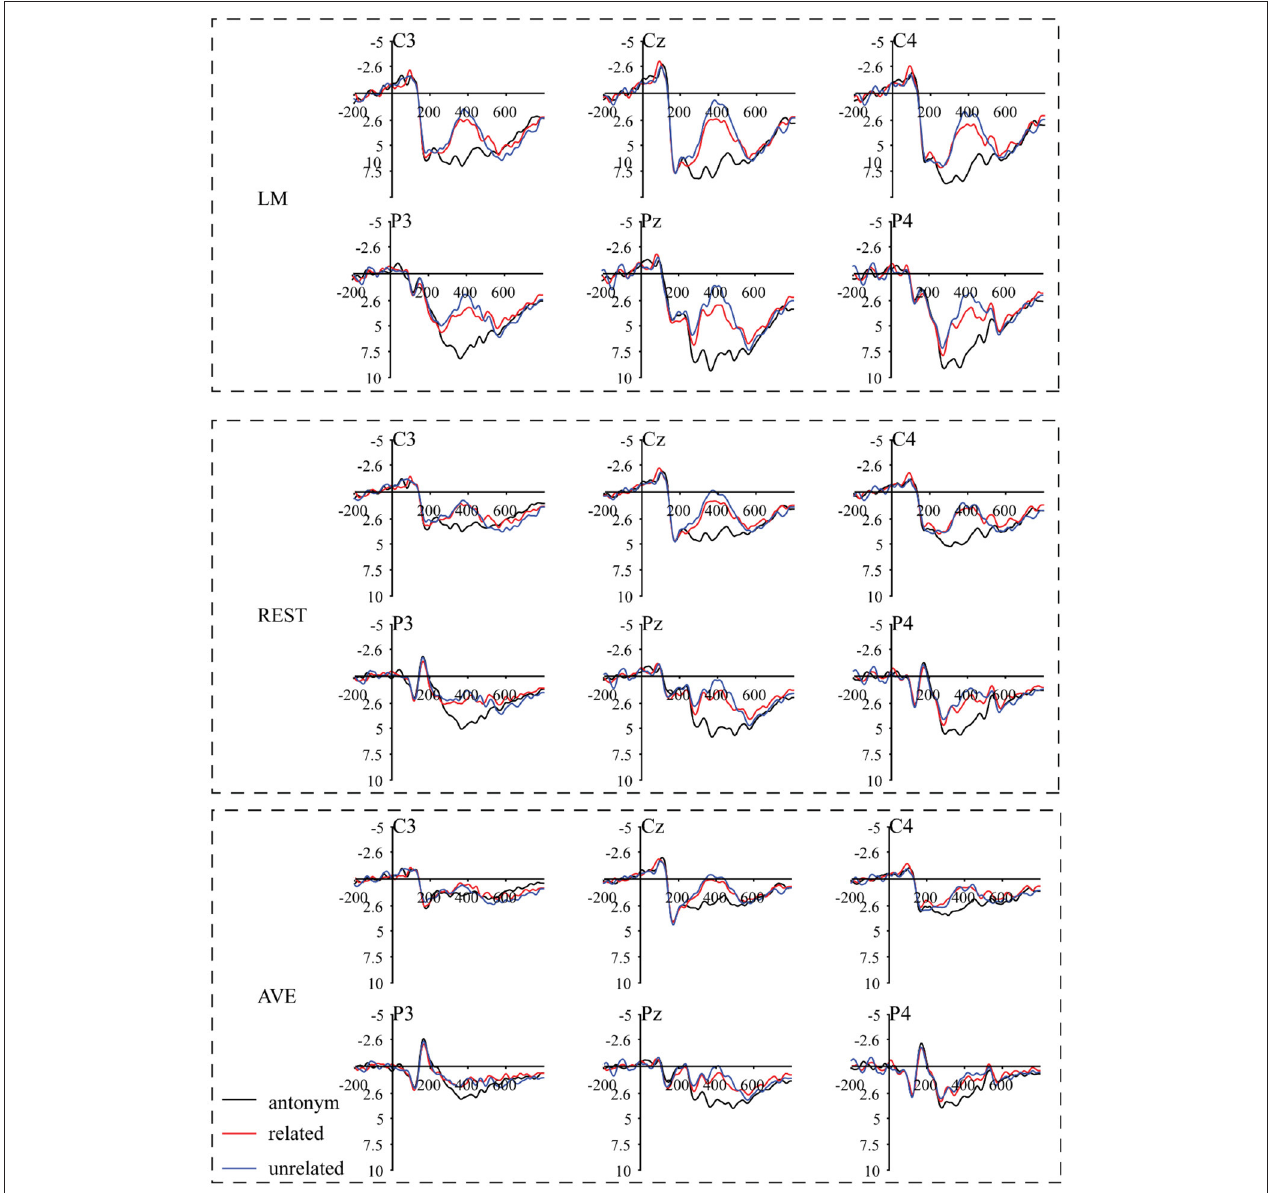
FIGURE 4 | Grand-average ERP waveforms under the antonyms, related and unrelated conditions in an antonym relations task using three separate reference approaches. The second word (Y), as the feedback stimulus onset, occurred at 0ms. Negativity is plotted